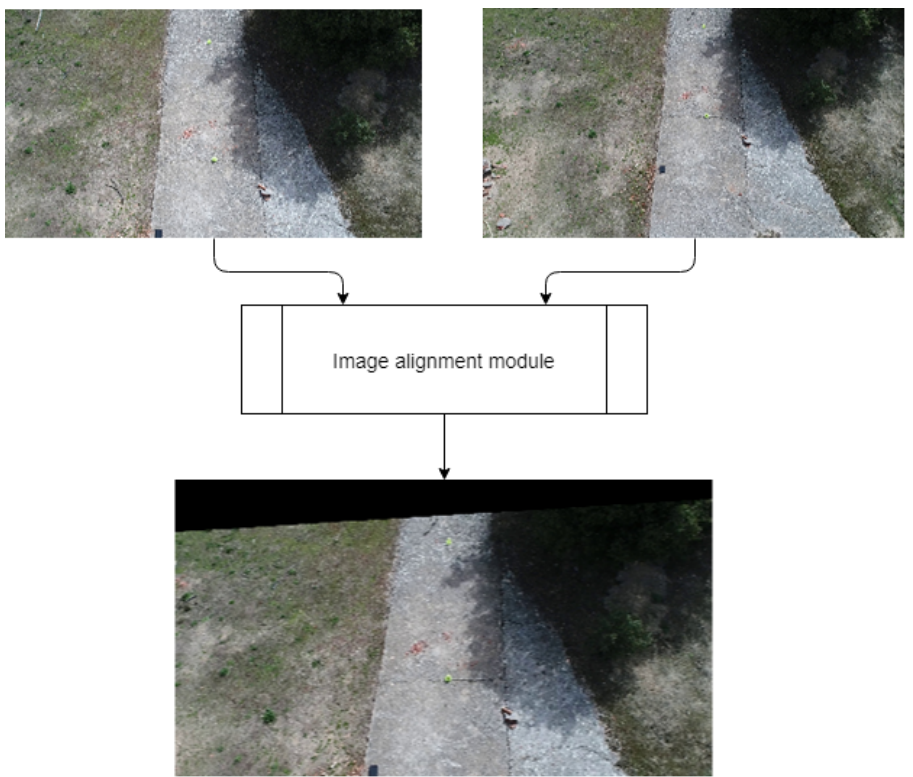
Figure 2. Example of our image alignment module’s output with a foreground image with significant difference from the